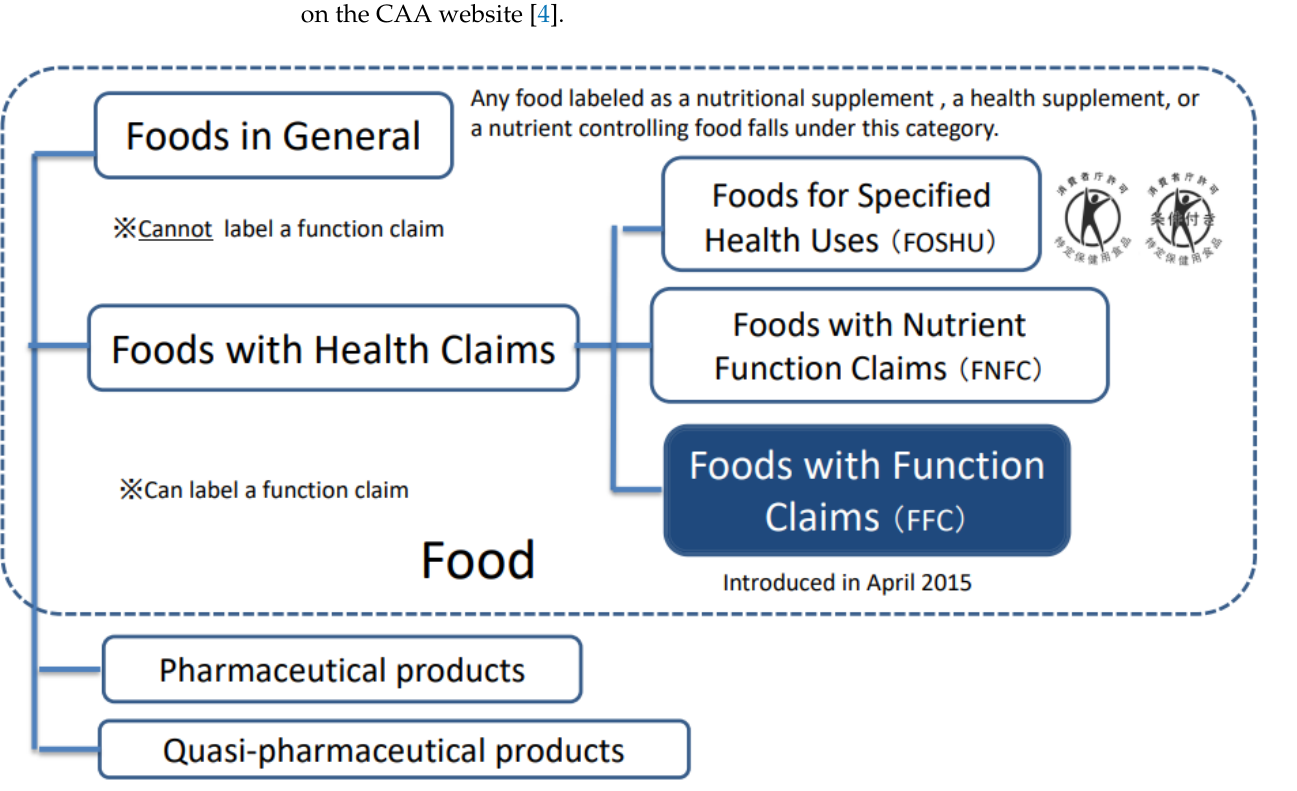
Figure 1. Food labeled with certain nutritional or health functions in Japan (modified partially for this study based on the Consumer Affairs Agency website in Japan). The new system (FFC) allows labeling, which indicates that the food is expected to have a specific effect on health, except for reducing the risk of diseases, through the process of submission to the Secretary-General of the Consumer Affairs Agency in Japan.